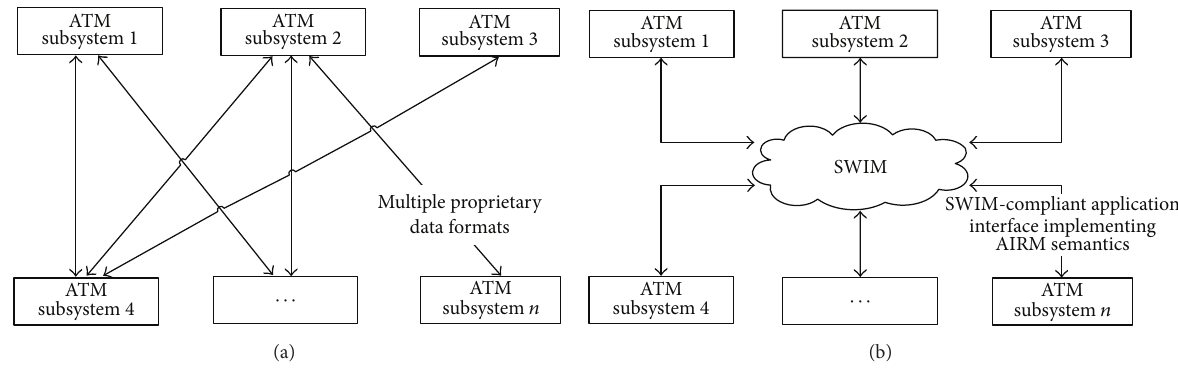
Figure 1: (a) The current Air Traffic Management (ATM) systems use legacy point-to-point connections with proprietary data formats. (b) This shall be replaced by the SWIM service oriented architecture for air traffic